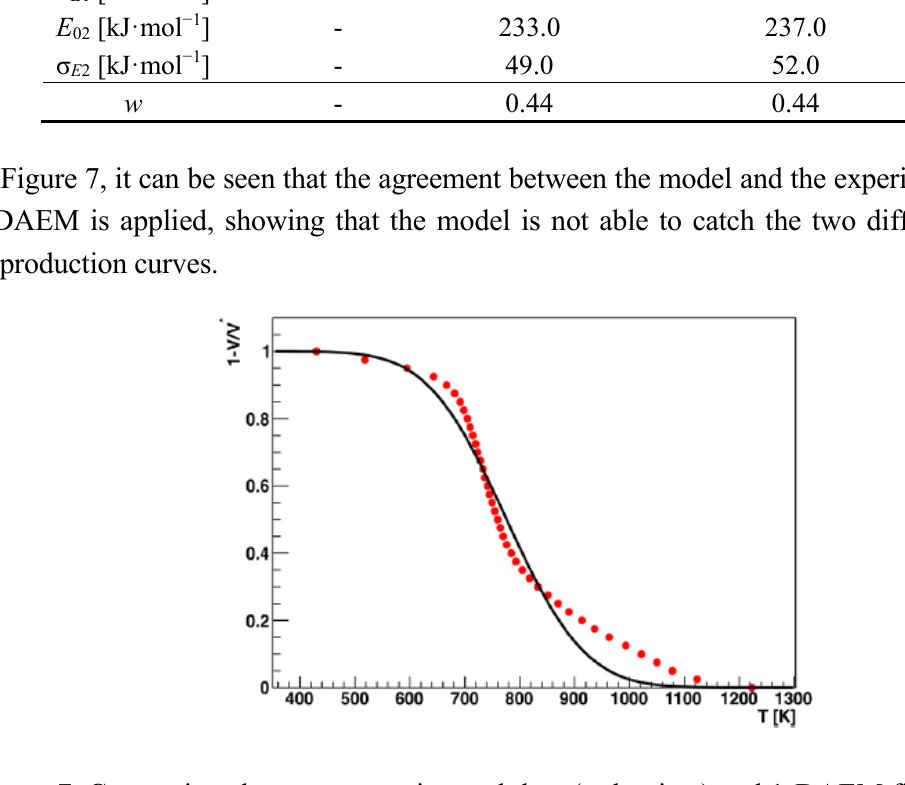
Figure 7. Comparison between experimental data (red points) and 1-DAEM fit (black line) for Sulcis coal at 100 K·min −1